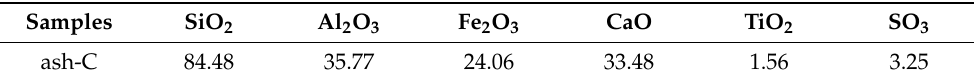
Table 2. Ash contents of ash-C